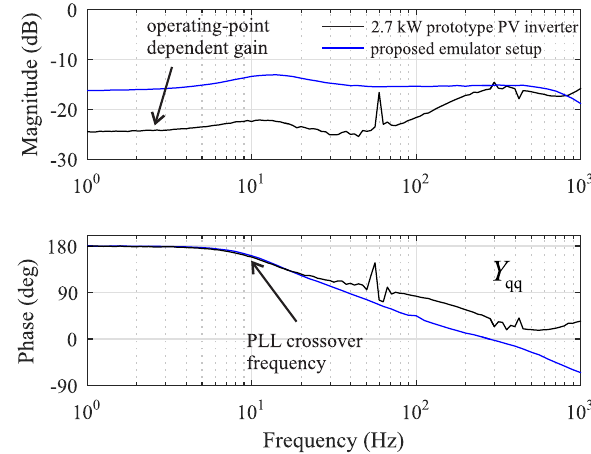
Figure 14. Admittance q-component measured from emulator and 2.7 kW PV inverter